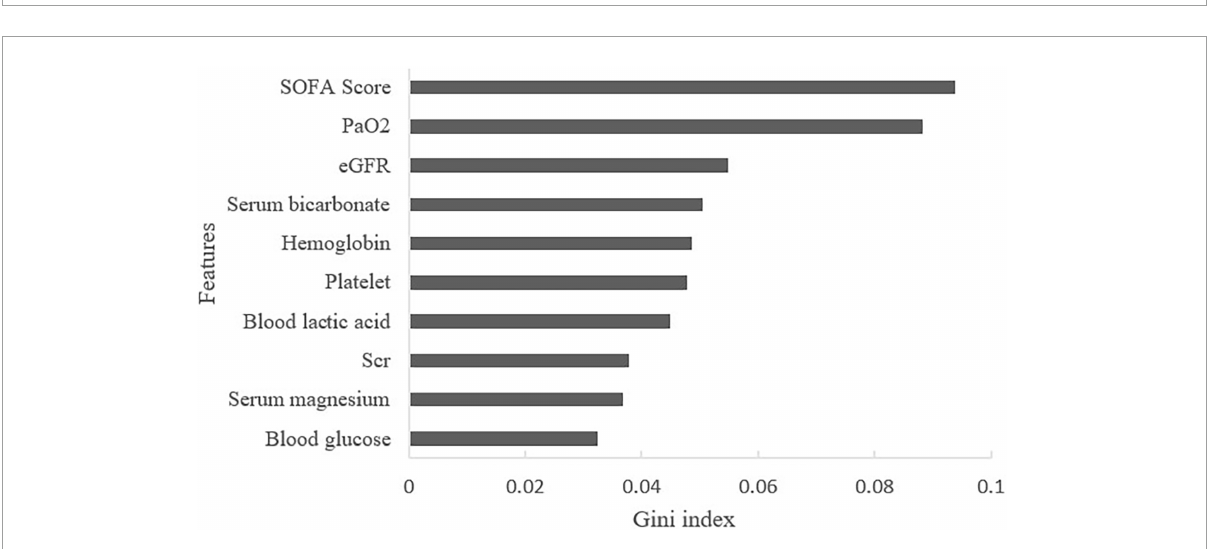
FIGURE4 Contribution of features of AKI in HF patients (Top 10 displayed). SOFA, sequential organ function assessment score; PaO 2 , partial pressure of oxygen; eGFR, estimated glomerular filtration rate; Scr, serum